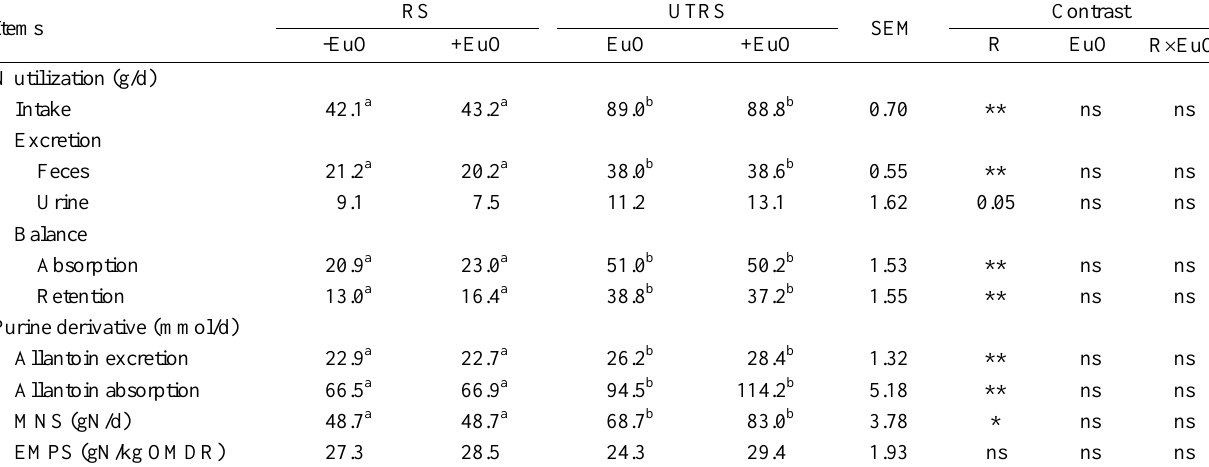
Table 5. Effects of roughage source and Eucalyptus crude oils supplementation on nitrogen metabolism and microbial protein synthesis Items